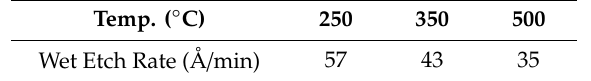
Table 1. Wet etch rate of the RPALD SiN x film as a function of deposition temperature. Temp. ( ◦